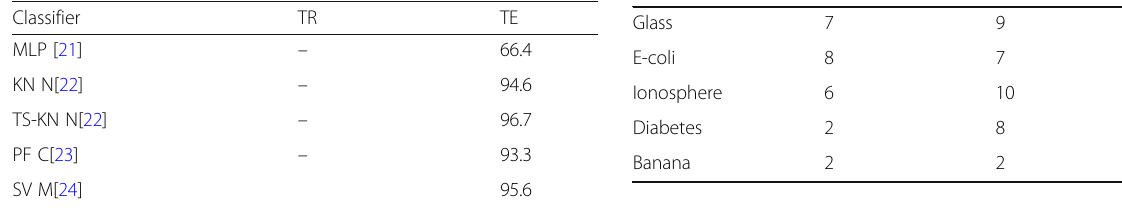
Table 2 Comparison of classification rate with previous classifiers (Iris data)